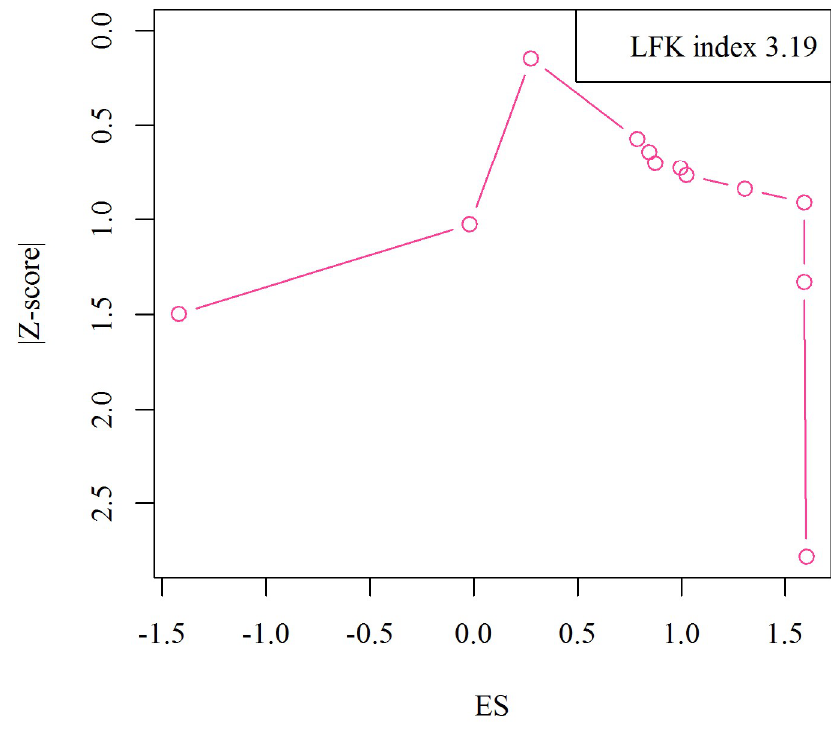
Figure 6. Doi plot analysis and LFK index of publication bias.